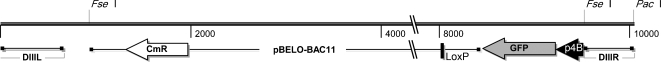
Schematic of construct for recombination into deletion III locus of MVA, based on pBELO-BAC11.DIIIL and DIIIR = left and right flanks for homologous recombination into MVA genome; GFP = green fluorescent protein gene; p4B = Fowlpox virus late promoter; CmR = chloramphenicol acetyltransferase gene for selection in E. coli. Flanking FseI sites are absent from MVA and permit excision of the cassette. The PacI site is provided for linearisation of the plasmid prior to recombination with MVA in infected transfected cells.